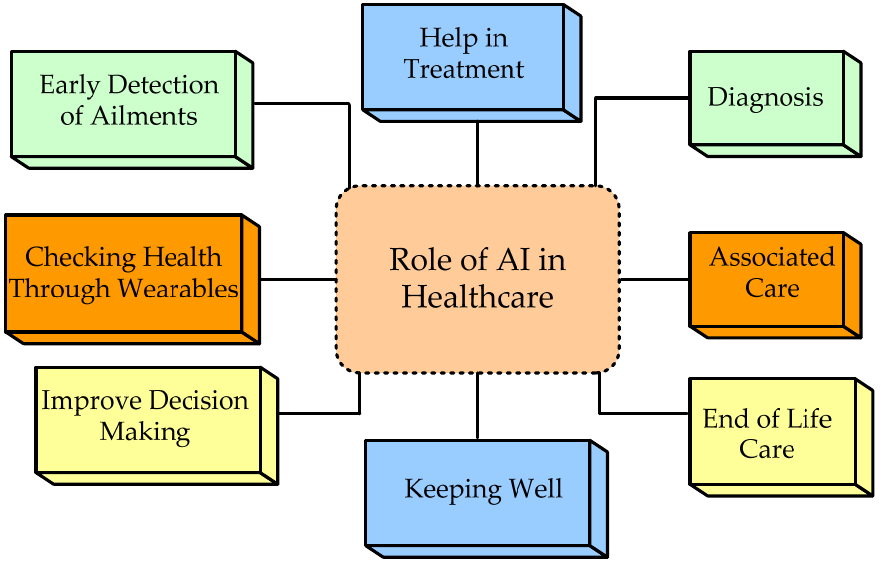
Figure 5. Role of artificial intelligence in